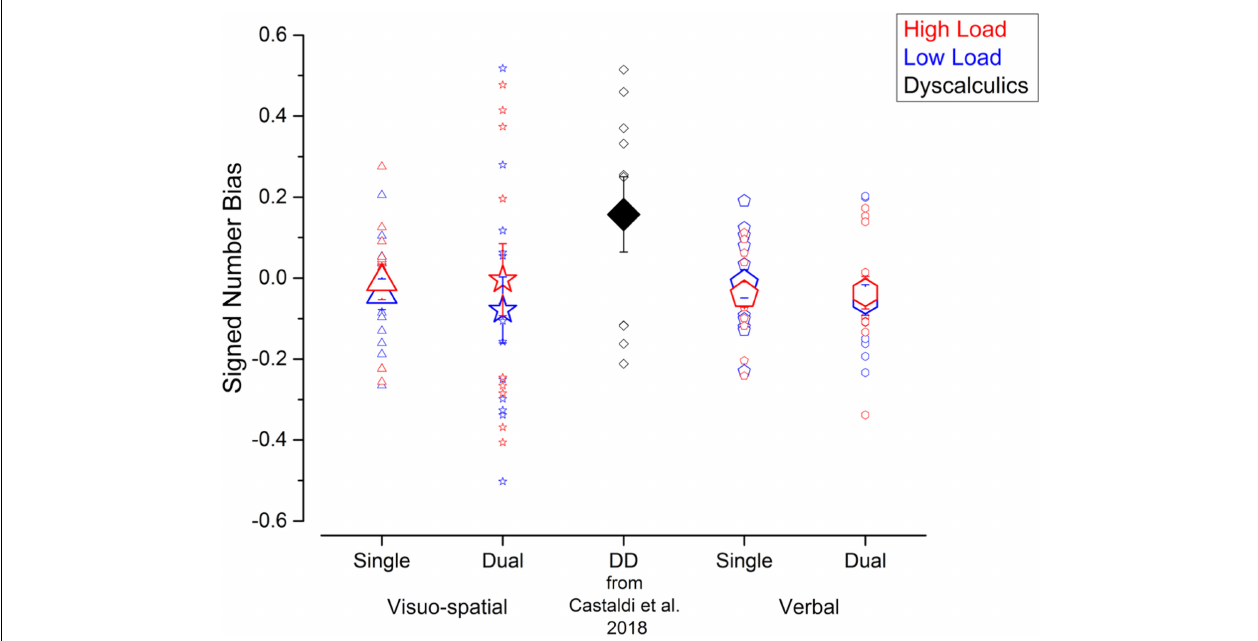
FIGURE 3 | Interference from the unattended dimension in the numerosity discrimination tasks – signed bias. Signed biases measured in the different experiments performed in the current study (blue and red symbols) and in a group of DD participants (black symbol, for qualitative comparison) tested by Castaldi et al. (2018). Symbol size and color correspond to the average and individual biases and to the different loads in the secondary task.